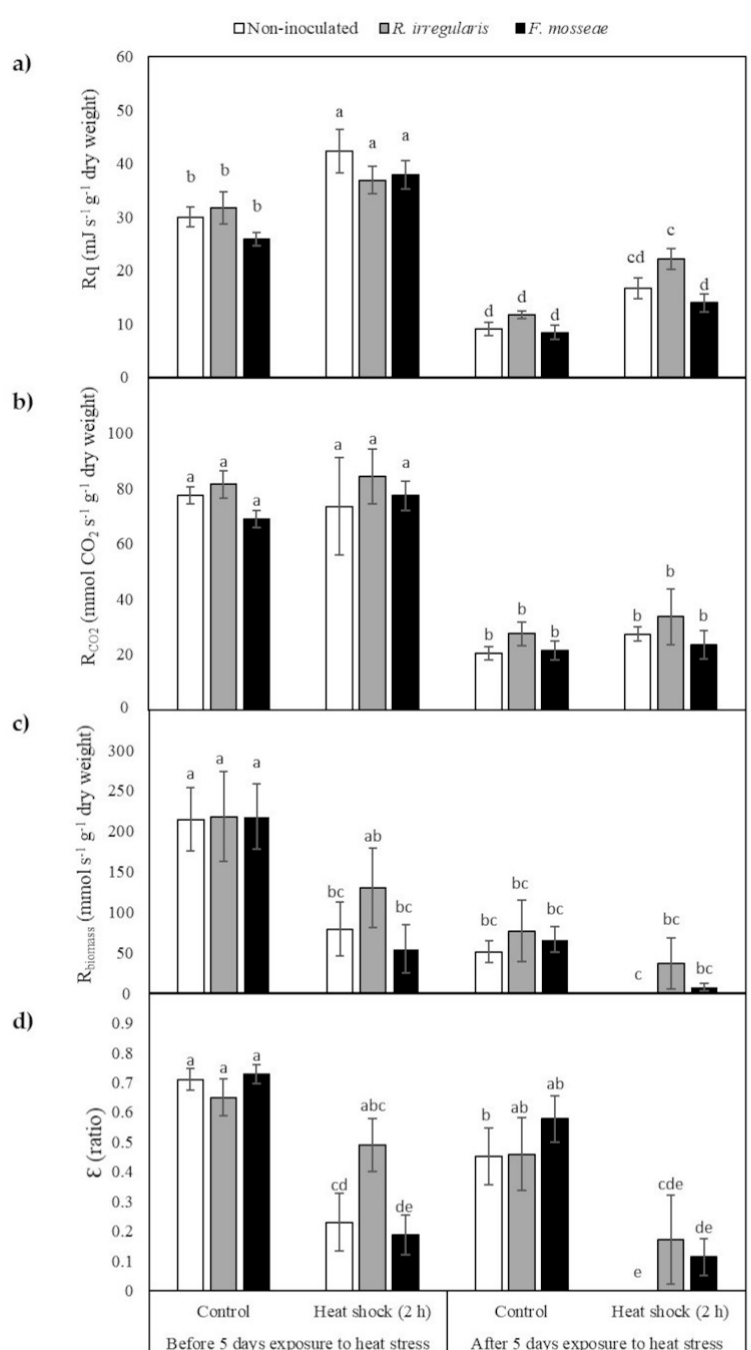
Figure 5. Calorespirometric parameters. ( a ) Metabolic heat rate, R q ; ( b ) CO 2 production rate, R co2 ; ( c ) Structural biomass formation rate, R biomass ; ( d ) Carbon use e ffi ciency, E . Bars represent the average of five samples ± standard error. Di ff erent letters indicate significant di ff erences according to pairwise multiple comparisons conducted using the simulation method of Edwards and Berry [70]. Significant e ff ect, p -value <